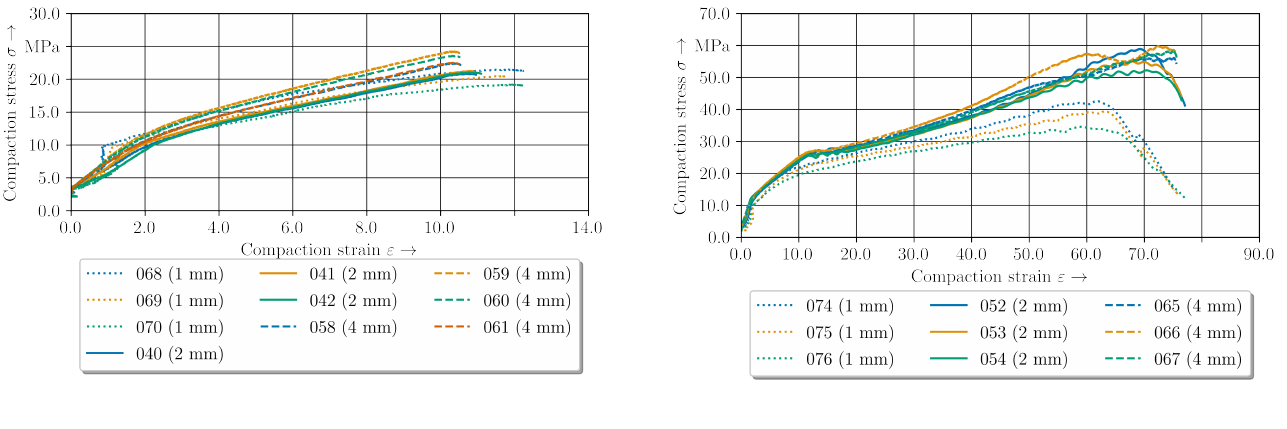
Figure 13. Compaction curves at 180°C for three configurations. ( a ) 10% compaction level. ( b ) 75% compaction